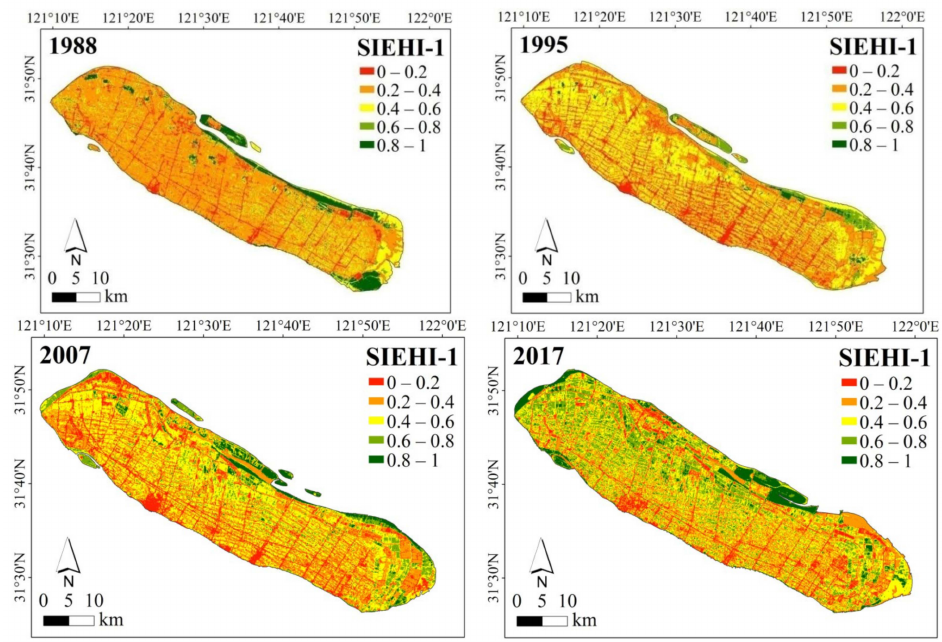
Figure 7. Maps of SIEHI-1 in the four years: SIEHI-1: Part 1 of the sandy island ecosystem health